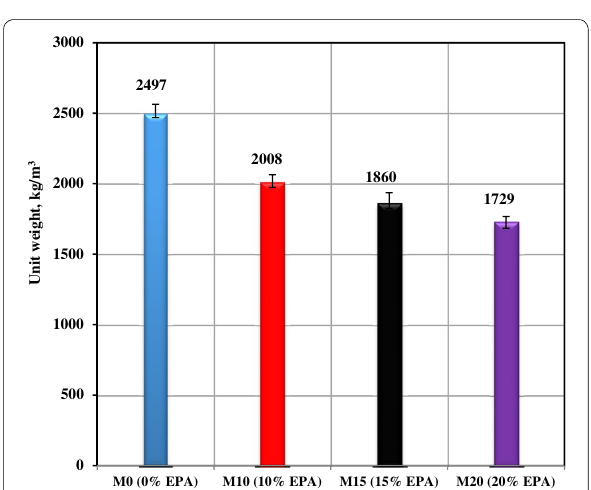
Fig. 5 Unit weight of concrete containing varying quantity of EPA.